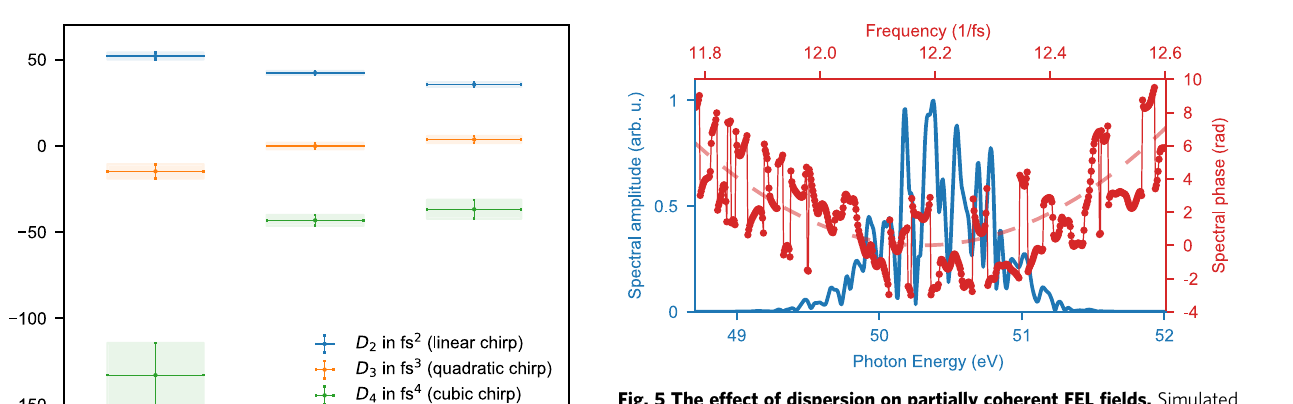
Fig. 5 The effect of dispersion on partially coherent FEL fi elds. Simulated spectral phase and amplitude of a 50.27-eV center-photon energy FEL pulse with a 50-fs temporal duration and a coherence length of 3 fs obtained from the model introduced in ref. 24 . The parabolic phase offset (indicated by the red dashed line) originates from an imposed linear chirp of D 2 =